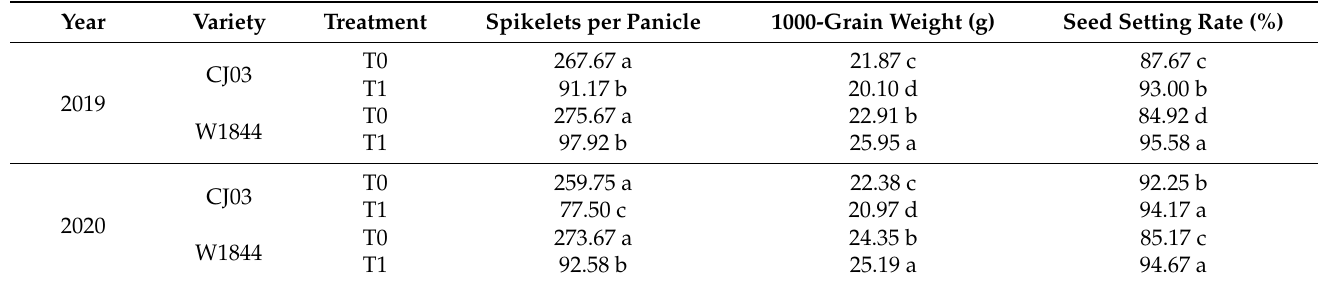
Table 1. Agronomic traits of japonica rice materials at maturity.